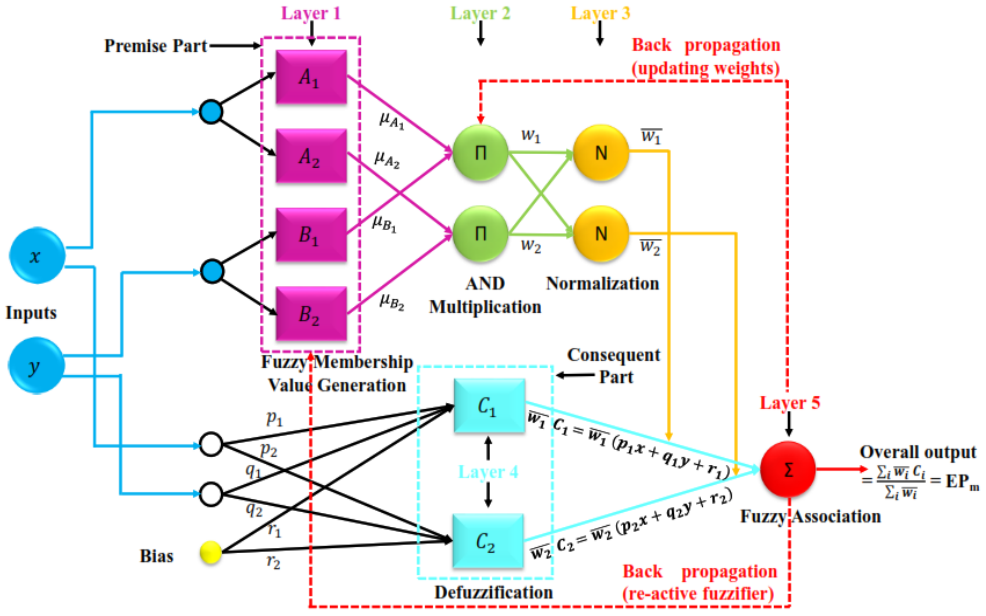
Figure 3. Hierarchy network of the co-active neuro-fuzzy inference system (CANFIS) model.